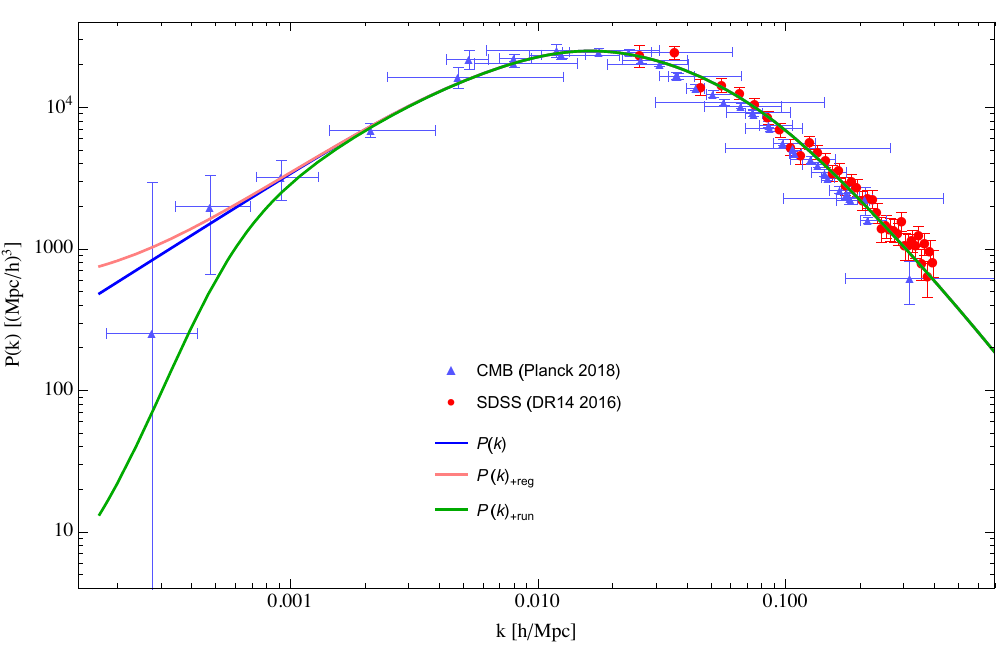
Figure 2. Matter power spectrum P ( k ) with various quantum effects included. The middle (blue) curve shows the full matter power spectrum function as predicted by quantum gravity, modulo the two following effects. The top (orange) curve P ( k ) reg includes the effect of an infrared (IR) regulator ξ ∼ 5300Mpc. The bottom (green) curve P ( k ) run includes both the effect of the IR regulator and a renormalization group (RG) running of Newton’s G , characterized by an amplitude of running 2 c 0 ∼ 16.04, as given by numerical calculations from the lattice theory [see Equations (4) and (6)]. The blue triangles show the Planck 2018 CMB data